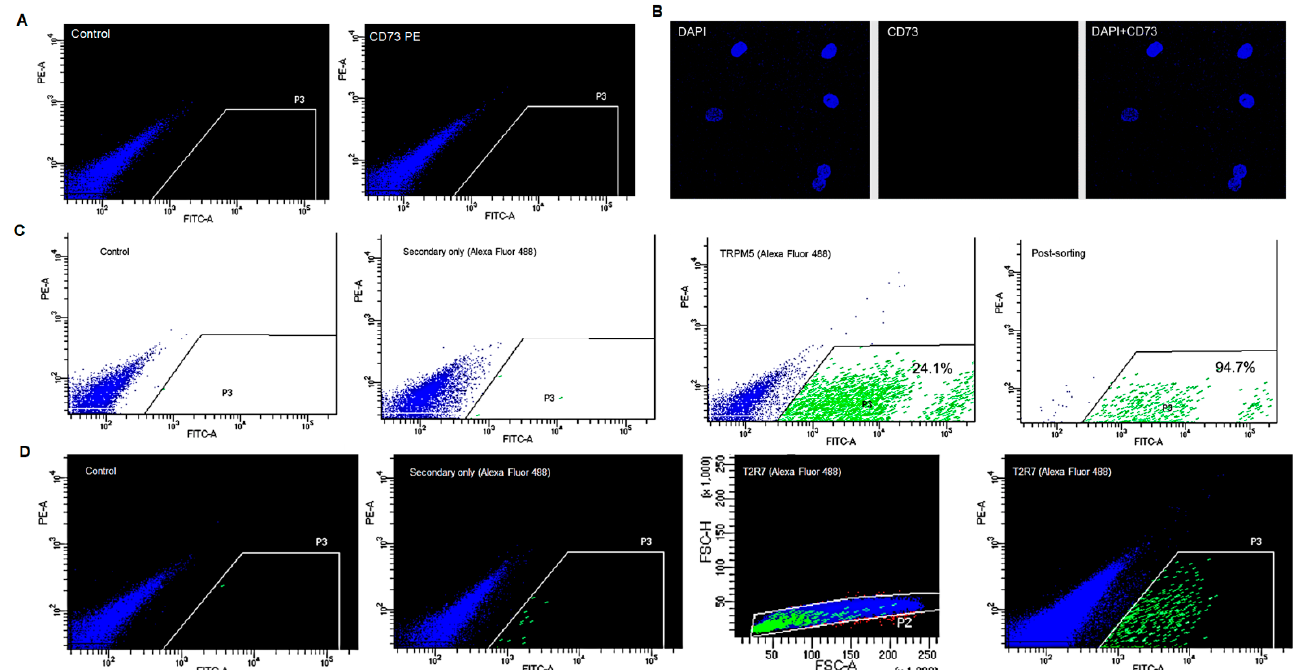
Figure 5. Flow cytometry analysis of cultured BTBCs. ( A ) BTBCs stained with anti-CD73 antibody; ( B ) confocal images to detect the expression of CD73 in BTBCs; DAPI stained nucleus (blue), protein of interest stained with anti-CD73 and combined pictures; ( C ) flow cytometry analysis of TRPM5-positive BTBCs showing negative control, secondary-only control, TRPM5-positive BTBCs (24.1%) and post-sorting purity analysis (94.7%); and ( D ) flow cytometry analysis of T2R7-positive BTBCs showing negative control, secondary-only control, excluded doublets shown as red dots outside the FSC-H vs. FSCA data plot and T2R7-positive BTBCs